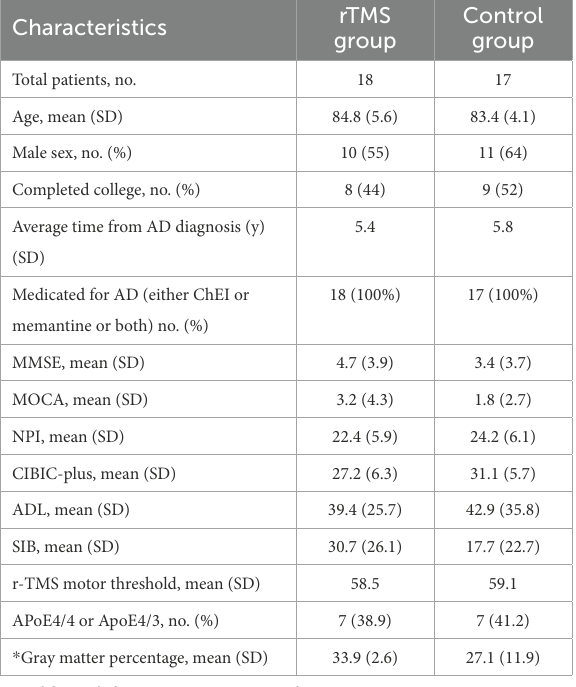
TABLE 1 Baseline participant